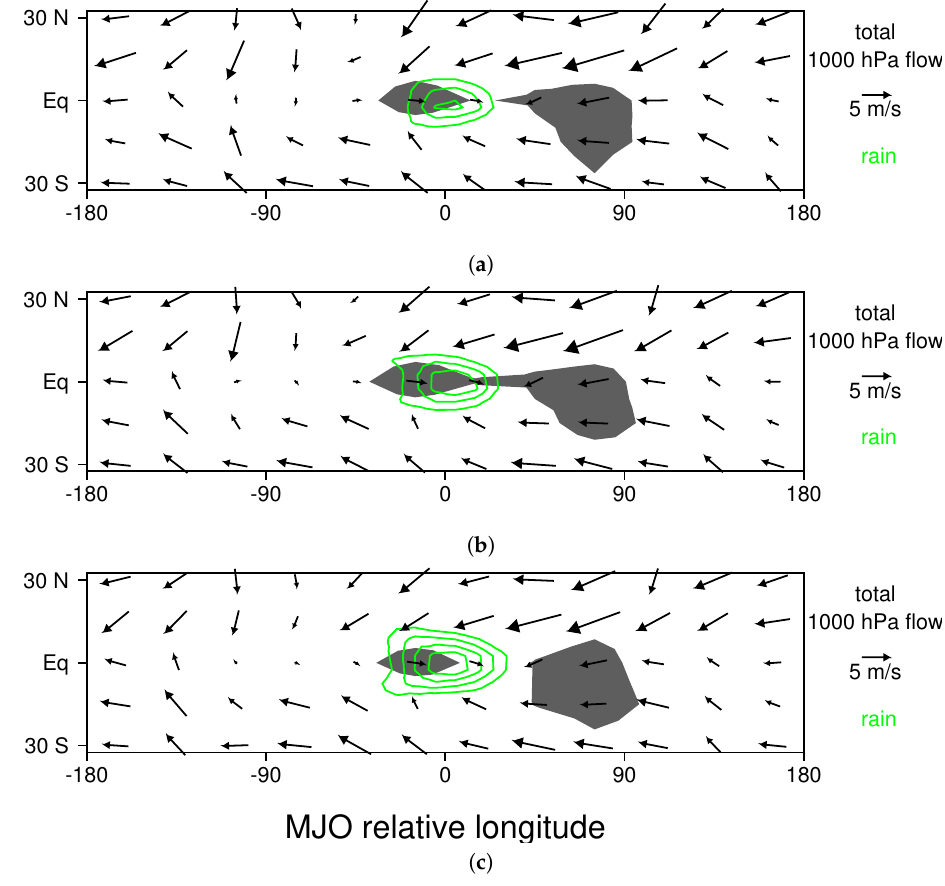
Figure 8. Total 1000 hPa flow in MJO relative coordinates for the mature stage of the MJO: ( a ) the control simulation; ( b ) the 3 K warming experiment; and ( c ) the 7 K warming run. Regions in which the MJO wind perturbation causes the speed of the flow to increase by more than 1 m/s are shaded dark gray. Perturbation rainfall is contoured in green for 3, 5, 7, and 9